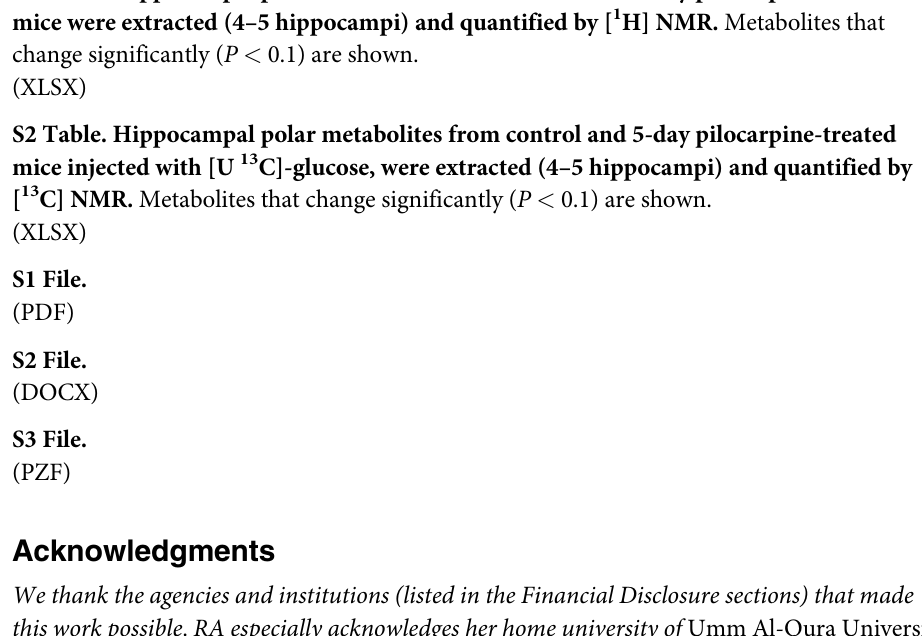
day 5 following SE with pilocarpine (Pilo) or control (saline). (n = 4–6 mice/group). Data are represented as mean ± SEM. P > 0.05, by unpaired student’s t -test using Prism 9.0 (Graphpad). Refer to supplemental materials for more details on the number of replicates and statistical analyses for each experiment. S5 Fig. Glycolytic inhibitor 2-DG does not alter PDH activity. (A) Confocal images (X63) of positive pPDH S293 (red) neuronal cells that are not changed in the DG region of 5 days post- SE in hippocampus 2-DG-treated pilocarpine mice when compared to control pilocarpine mice. [GFAP (green) and Dapi (blue)]. S6 Fig. Induced seizure sensitivity in HBP1 -/- KO mice for C57BL/6 strain. (A) Representa- tive western blot with quantified data of baseline levels of Wnt and mTOR signaling markers in C57BL/6 mouse strain were increased in HBP1 -/- Knockout (KO) and HBP1 +/- heterozy- gous (HET) when compared to control (WT). (B) HBP1 -/- KO mice have increased number and severity of seizures after seizure induction based on the Racine scale [73] (n = 3–5 mice for each group). Data are represented as mean ± SEM. � P < 0.05 by unpaired student’s t -test using Prism 9.0 (Graphpad). Refer to supplemental materials for more details on the number of replicates and statistical analyses for this experiment. S1 Table. Hippocampal polar metabolites from control and 5-day pilocarpine-treated mice were extracted (4–5 hippocampi) and quantified by [ 1 H] NMR. Metabolites that change significantly ( P < 0.1) are shown. S2 Table. Hippocampal polar metabolites from control and 5-day pilocarpine-treated mice injected with [U 13 C]-glucose, were extracted (4–5 hippocampi) and quantified